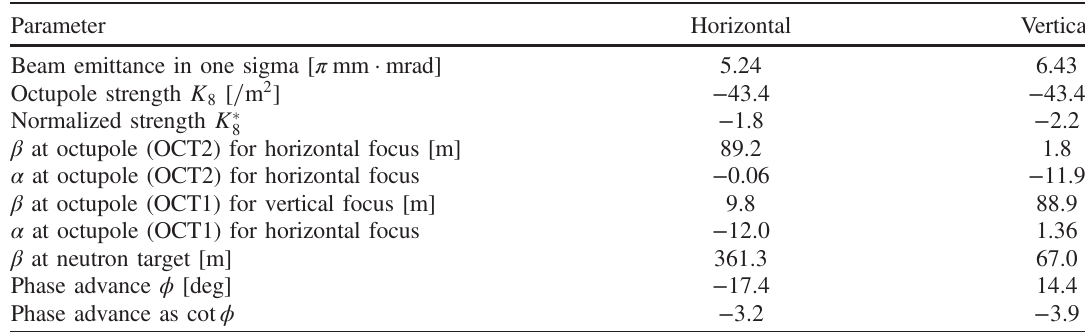
TABLE II. Beam parameters of nonlinear optics used in the spallation neutron source in J-PARC. Parameter Horizontal